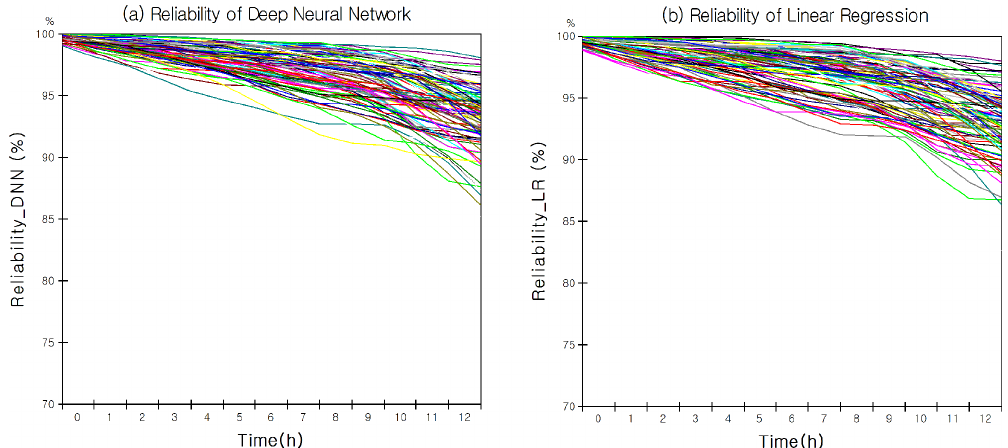
Figure 6. Training reliability by combining system dynamics and machine learning when predicting road temperature. (a) The graph means the reliability of the deep neural network by data acquisition date, and the average value is 93.01%. (b) The graph means the reliability of linear regression by data acquisition date, and the average value is 91.4%. The parameters of the DNN model and the LR model were optimised with the evolution algorithm. Table 4. Factor list and data information of system dynamics